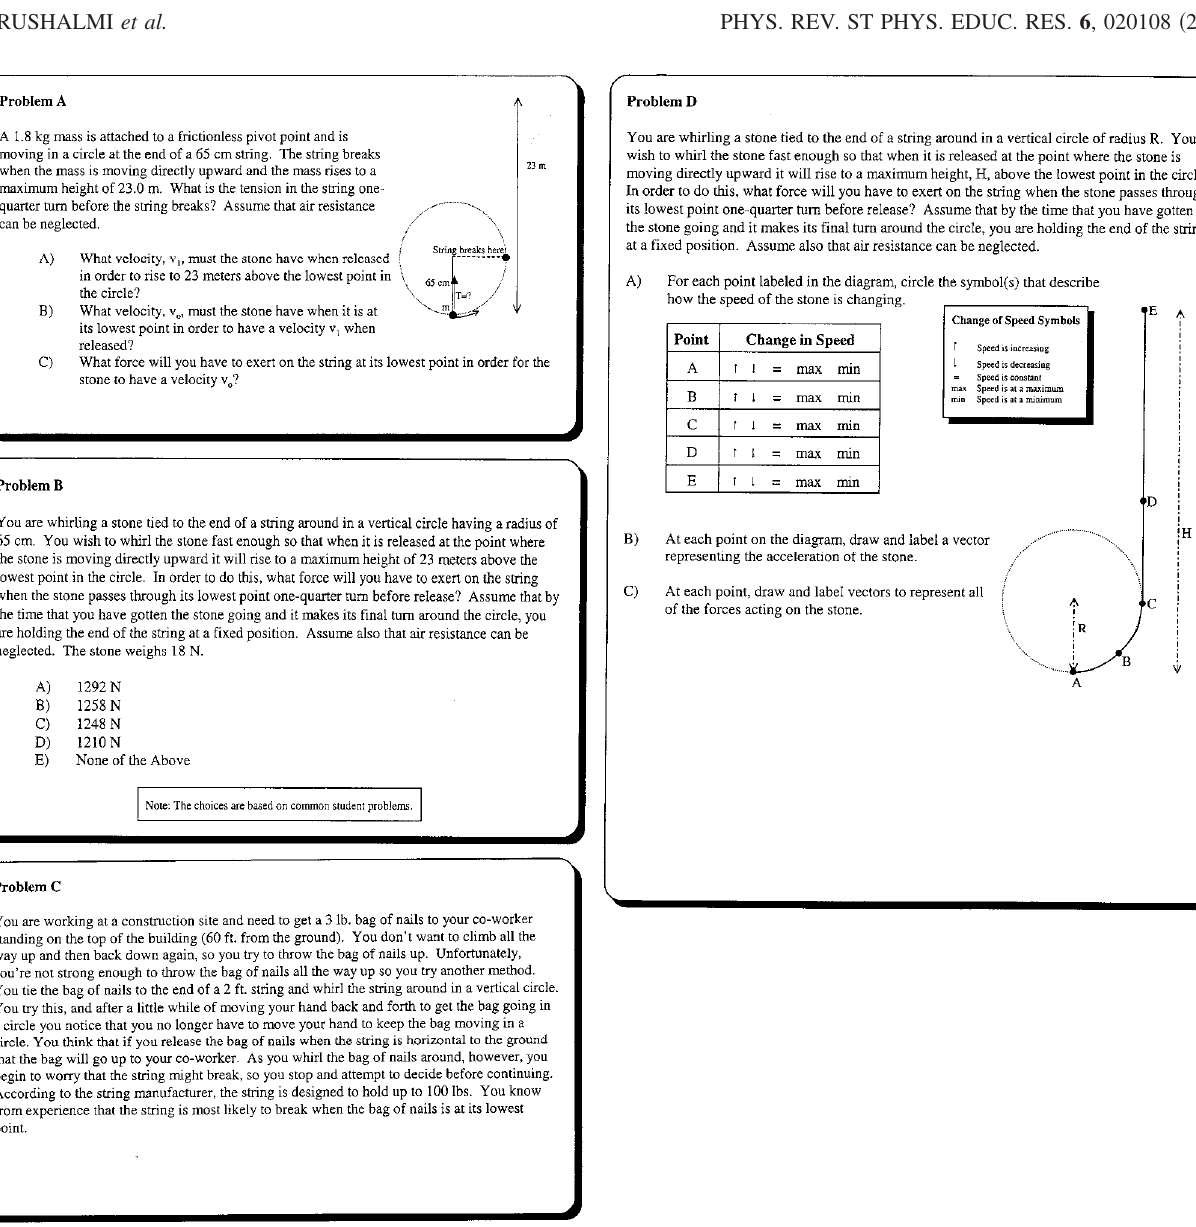
FIG. 2. Four problem variations that instructors were shown during the